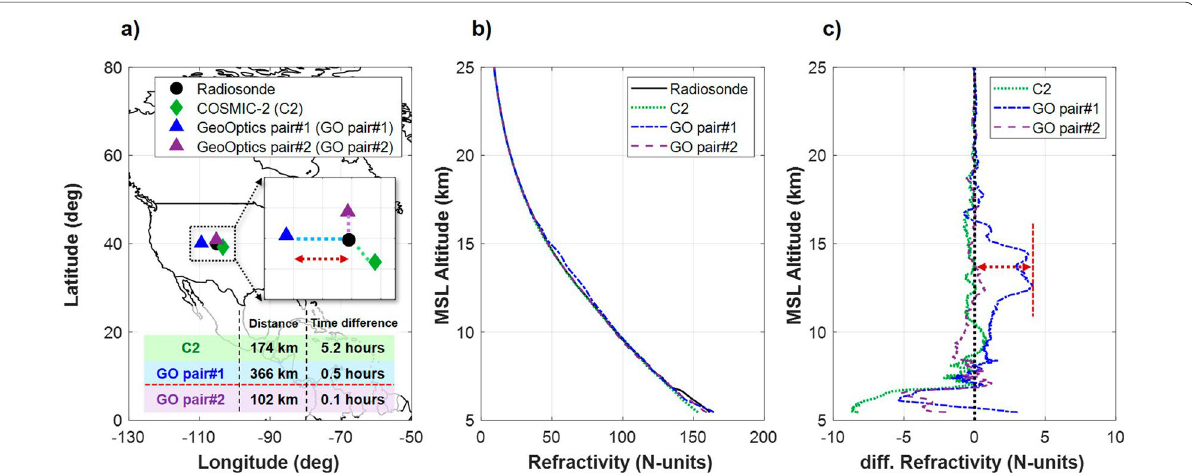
Fig. 12 a Locations, b refractivity profiles of radiosonde (black), COSMIC-2 (green), and GeoOptics (blue, purple) occultation events. c Refractivity differences of COSMIC-2 (green) and GeoOptics (blue, purple) occultation events compared to radiosonde observations